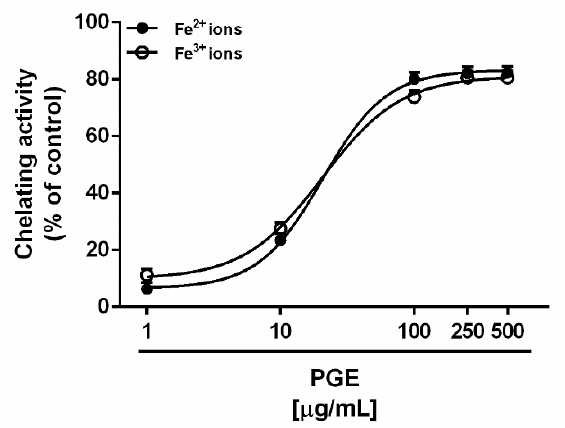
Figure 4. Chelating activity exhibited by the ethyl acetate Soxhlet extract of waste peel of Punica granatum L. var. Dente di Cavallo DC2 (PGE) towards ferrous (Fe 2 + ) and ferric (Fe 3 + ) ions. Each value granatum L. var. Dente di Cavallo DC2 (PGE) towards ferrous (Fe 2+ ) and ferric (Fe 3+ ) ions. Each value represents mean ± SEM ( n = represents mean ± SEM ( n = 4).